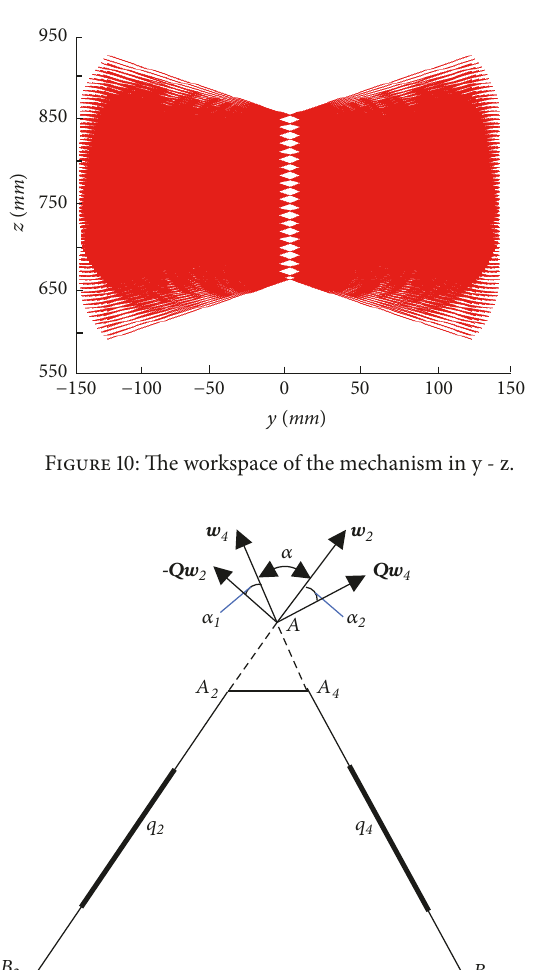
Figure 11: Pressure angles between RPU limbs.